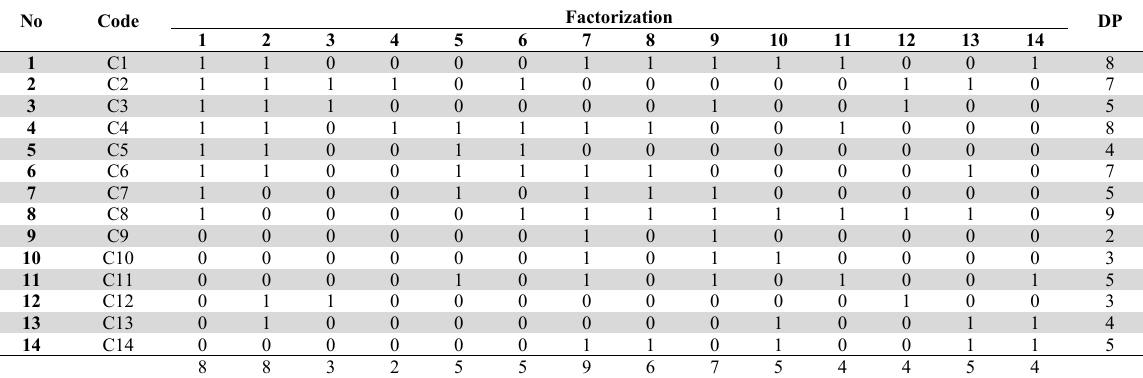
Reachability Matrix of Social Vulnerability